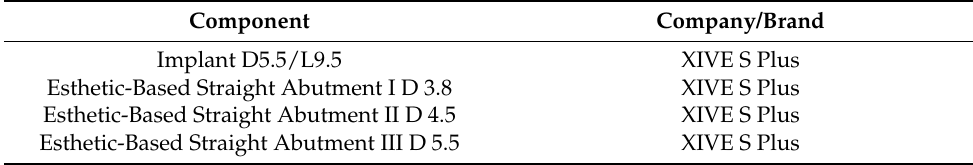
Table 1. Specifications of the dental implant system.